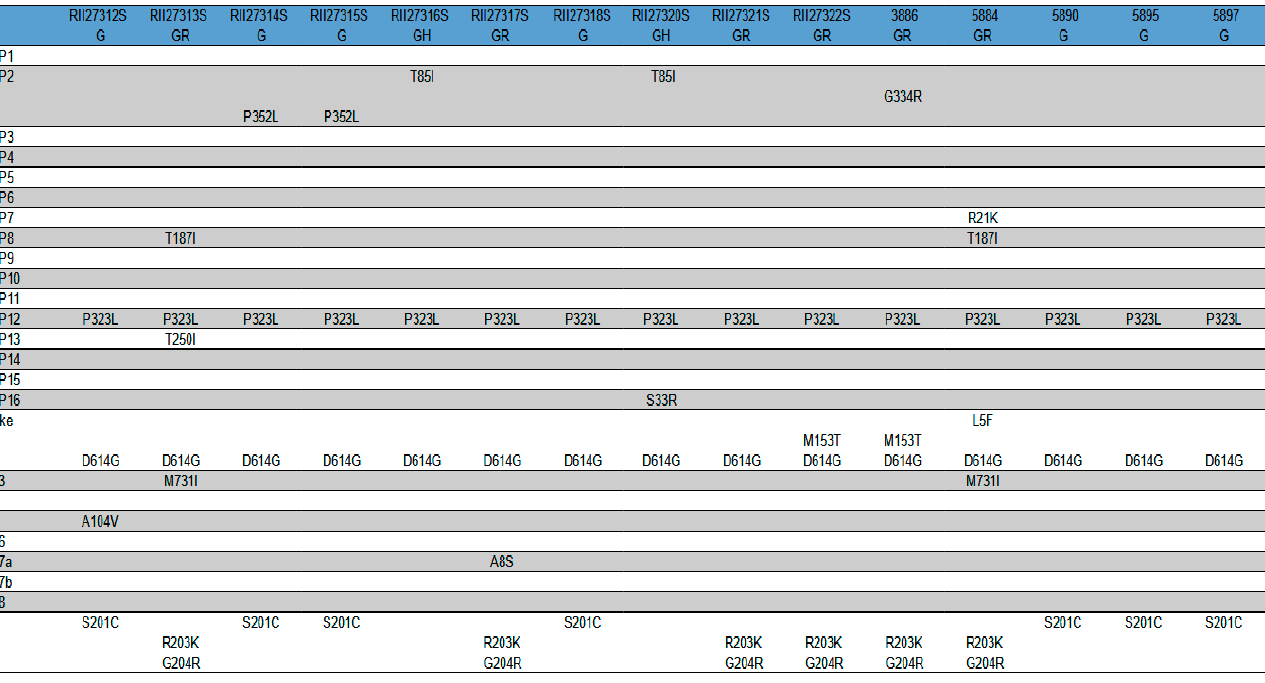
Figure 6. Amino acid substitutions in SARS-CoV-2 proteins from Novosibirsk according to the Wuhan reference hCoV-19/Wuhan/WIV04/2019 (WIV04).